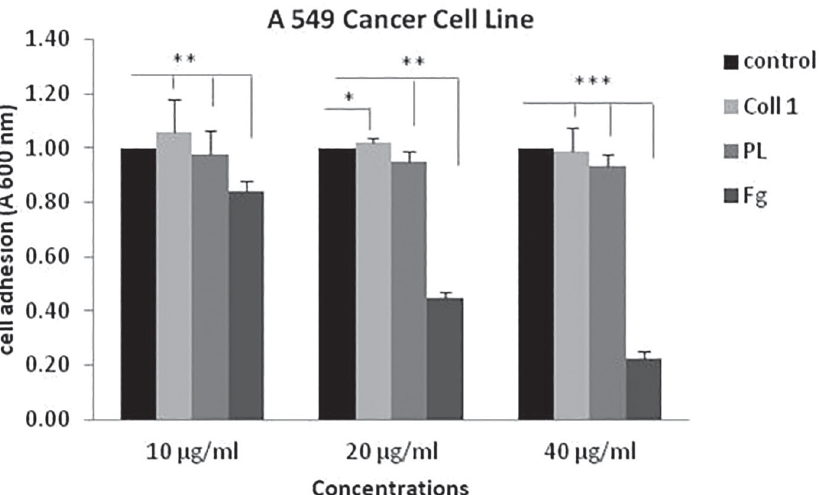
FIGURE 2 - Inhibition of human lung adenocarcinoma cell line (A549) adhesion by the Algerian propolis extract. A 549 cells were pre-incubated with different concentrations of the propolis extract and added to wells coated with 50 μg/mL fibrinogen (Fg), 10 μg/mL collagen I (Coll I), and 10 μg/mL poly-L-lysine (PL). Values are mean ± standard error of three independent experiments. p-value < 0.05: significant (*), p < 0.01: very significant (**), p ˂ 0.001: highly significant (***), NS (not